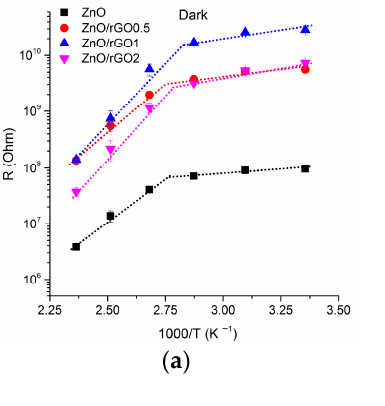
Figure 8. Temperature dependences of the resistance of ZnO nano fi bers and ZnO/rGO composites: ( a ) In dark conditions; ( b ) Under constant UV illumination (365 nm). ( c ) Temperature dependences of R dark / R UV ratio.